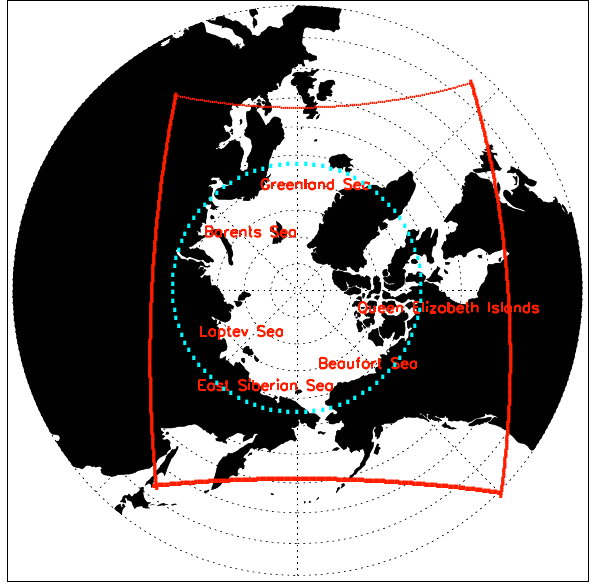
Fig. 1. Simulation domain (unrotated to normal longitude–latitude grid) of the CORDEX-Arctic experiments marked in red. Dashed circles indicate the latitudes in steps of five degrees. The light blue dashed circle indicates 67 ◦ N latitude, which is the lowest latitude line covered by the full interior domain (ten grid points from the marked domain) of the simulation.